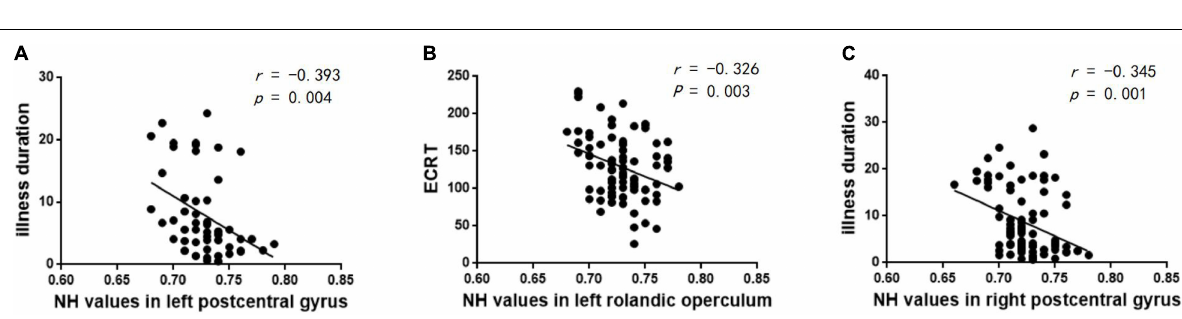
FIGURE 4 | Statistical maps showing NH differences in the right Rolandic operculum and the left postcentral gyrus between the rTLE group and the lTLE group. (Blue indicates lower NH and the color bar indicates the t -values from the two-sample t -test).